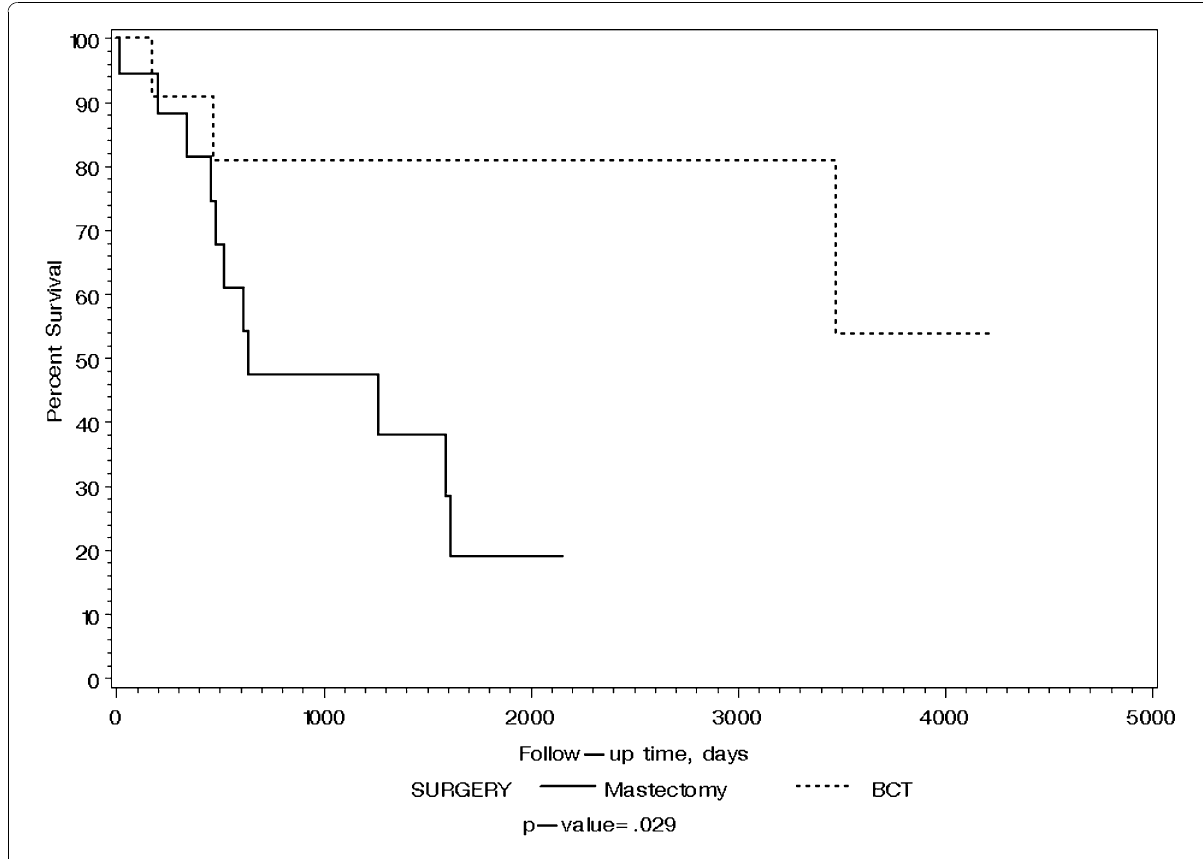
Figure 2 Survival of patients with BCT and mastectomy for treatment of MBC .